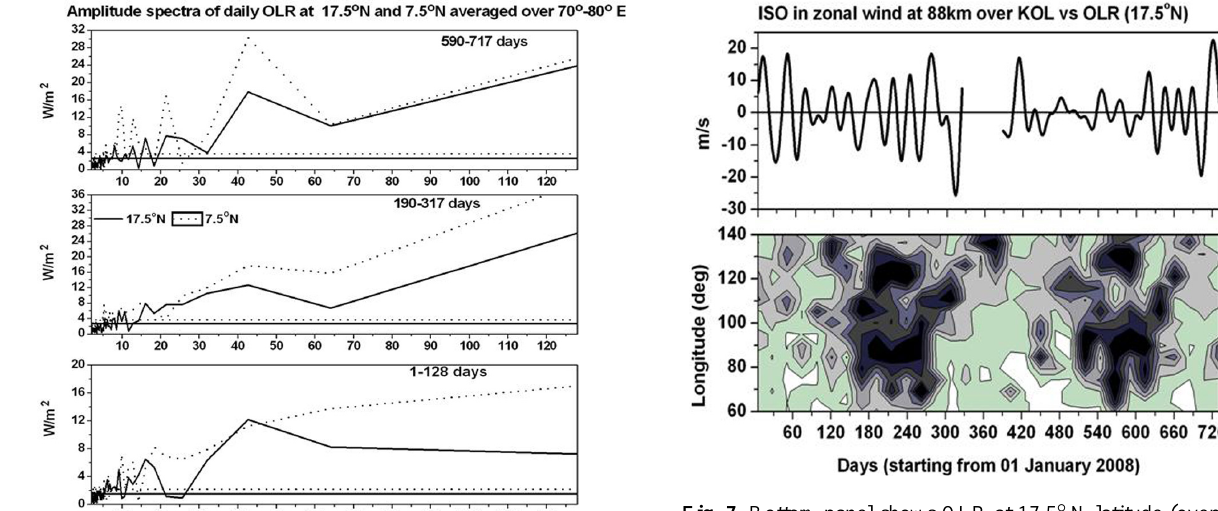
Fig. 7. Bottom panel shows OLR at 17.5 ◦ N latitude (over 60 ◦ E– 140 ◦ E longitude) and top panel shows the ISO in zonal wind at 88km over Kolhapur (KOL).